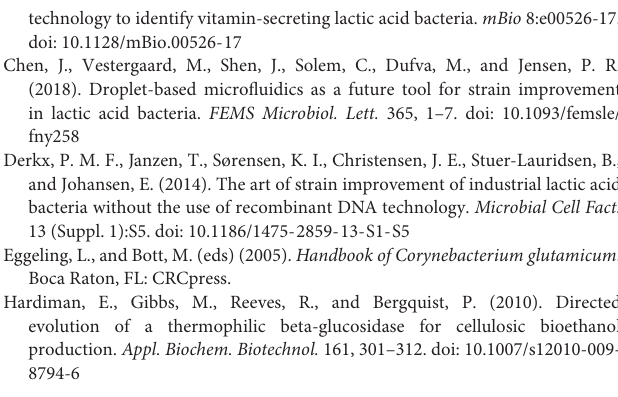
Supplementary Figure 2 | Microscopic view of droplet emulsion containing